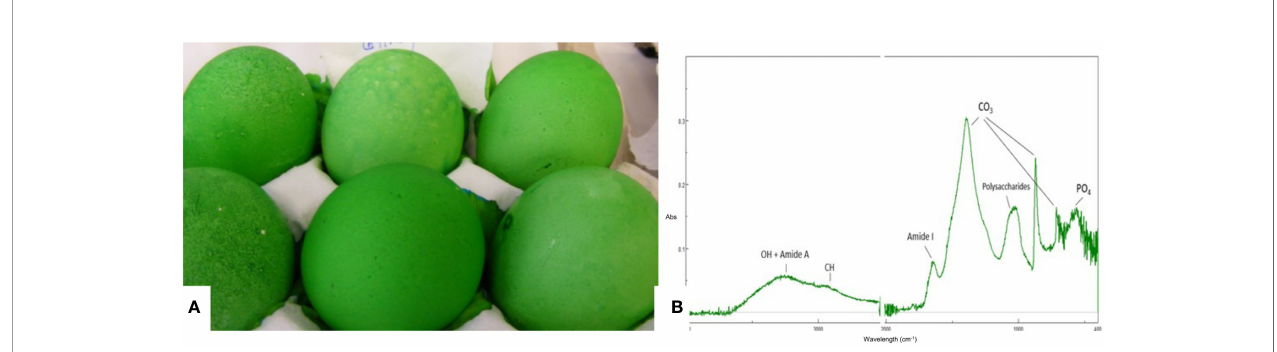
FIGURE 7 | Characterization of the eggshell cuticle. (A) Eggs demonstrating a good degree of uniform staining with MST cuticle blue dye; (B) ATR-FTIR spectra of an eggshell surface showing the main IR bands from the cuticle and from the shell mineral. (Original fi gure